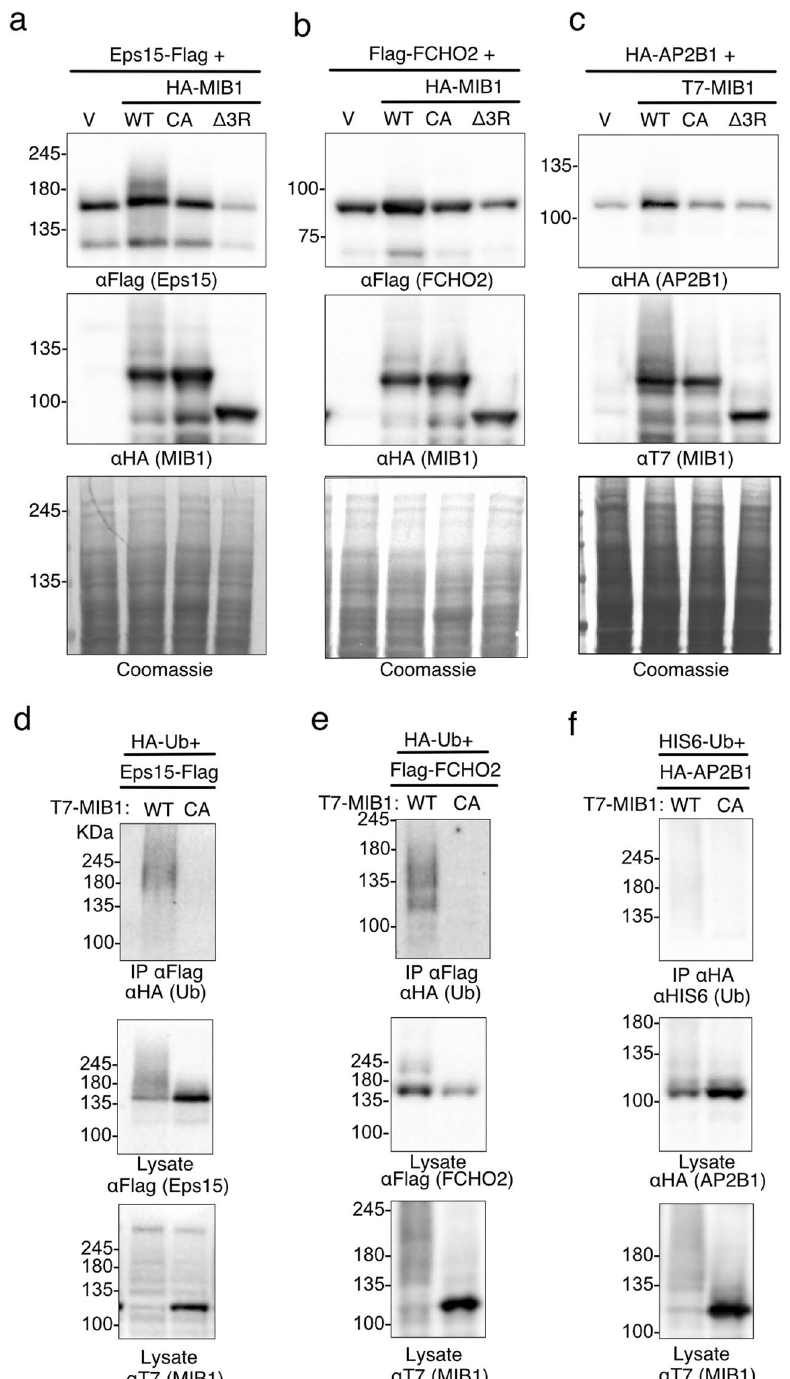
Figure 3. The endocytic proteins EPS15 and FCHO2 are ubiquitinated when co-expressed with MIB1. ( a – c ) Eps15-Flag, Flag-FCHO2 or HA-AP2B1 were individually co-transfected into HEK293T cells with either HA-tagged MIB1 WT, or mutants MIB-CA or MIB Δ 3 R (Eps15 and FCHO2 samples) or T7-tagged MIB WT and mutants (AP2B1 experiment). After 18 hours, cell proteins were extracted in 1xLaemmli lysis buffer and boiled. Equal concentrations of protein were separated by SDS-PAGE and immunoblotted with either anti- FlagM2, anti-HA (for MIB1 or AP2B1) or anti-T7 (MIB1). ( d – f ) Eps15-Flag, Flag-FCHO2, or HA-AP2B1 were co-transfected with T7-MIB1 or T7-MIB1CA mutant, and either HA-Ub (Eps15 and FCHO2) or HIS6-Ub (AP2B1). At 18 hours, cells were treated for 4 hours with 10 μ M MG132, followed by lysis in 1%SDS/RIPA lysis buffer and boiled. Tagged substrates were were immunoprecipitated from 2 mg of cell lysate as indicated, and immunoblotted with either anti-HA (Roche) or anti-HIStag to identify ubiquitinated proteins. Lysates (50 μ g) were immunoblotted to confirm substrate and T7-MIB1 expression. Each figure is representative of 3 (Eps15), 2 (FCHO2) and 1 (AP2B1) independent experiments. For clarity some blots were cropped. Full length blots are shown in Supplementary Fig.